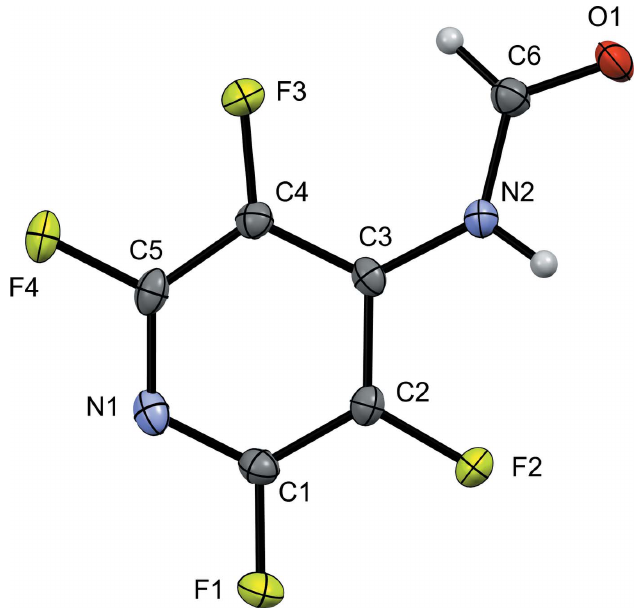
Figure 1 Displacement ellipsoid perspective view (50% probability) for the title structure showing the atom-numbering